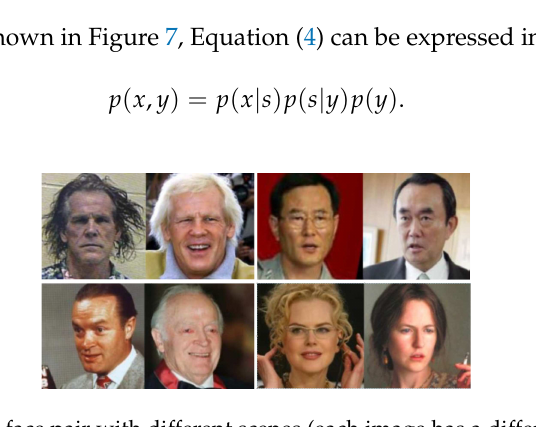
Figure 7. The face pair with different scenes (each image has a different